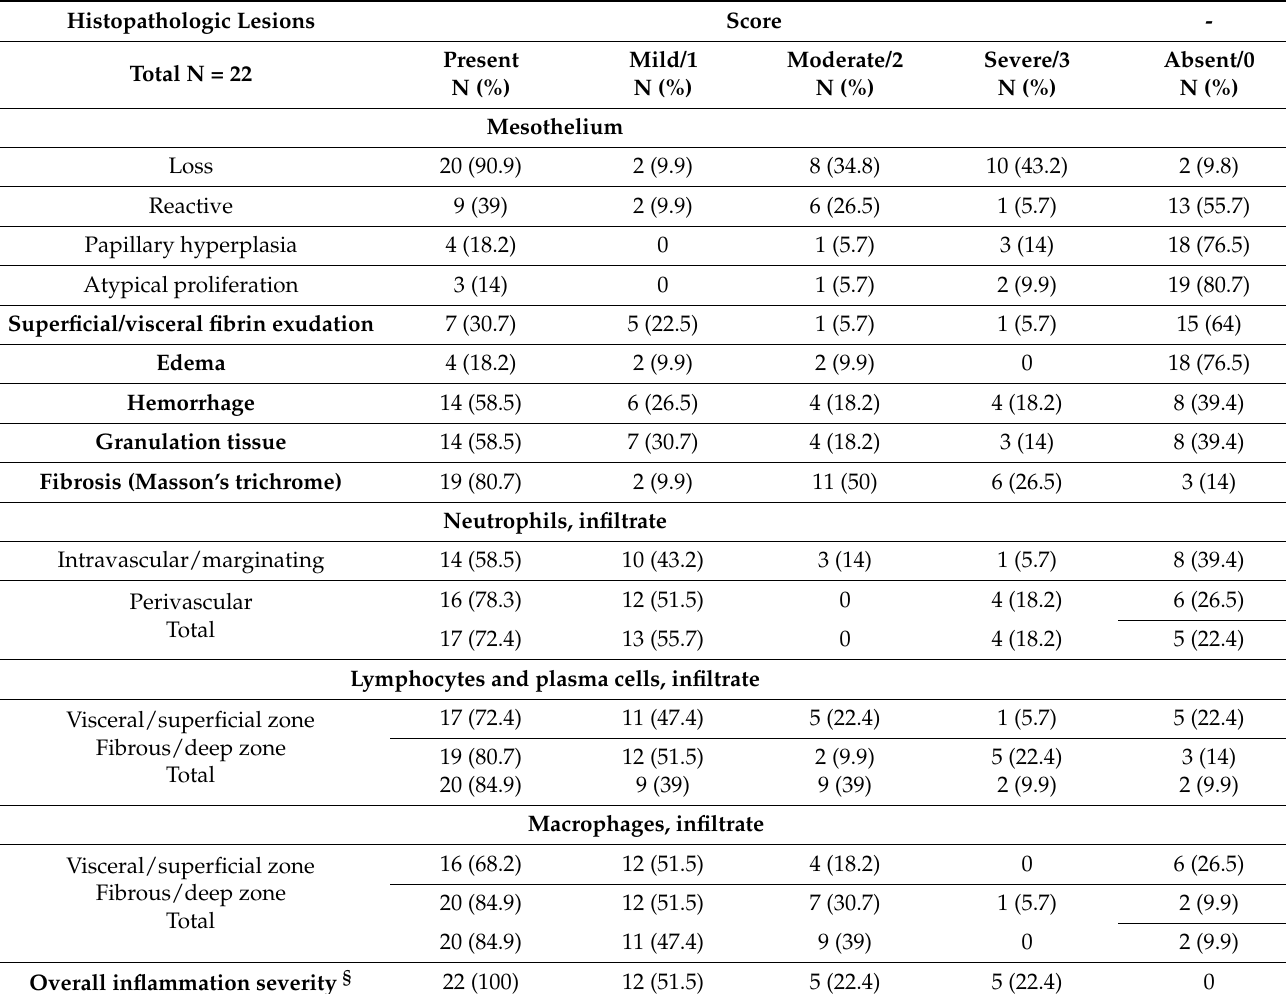
Table 2. Histopathologic lesions in pericardia affected by IP, evaluated on H&E sections, except fibrosis which was scored in Masson’s trichrome-stained